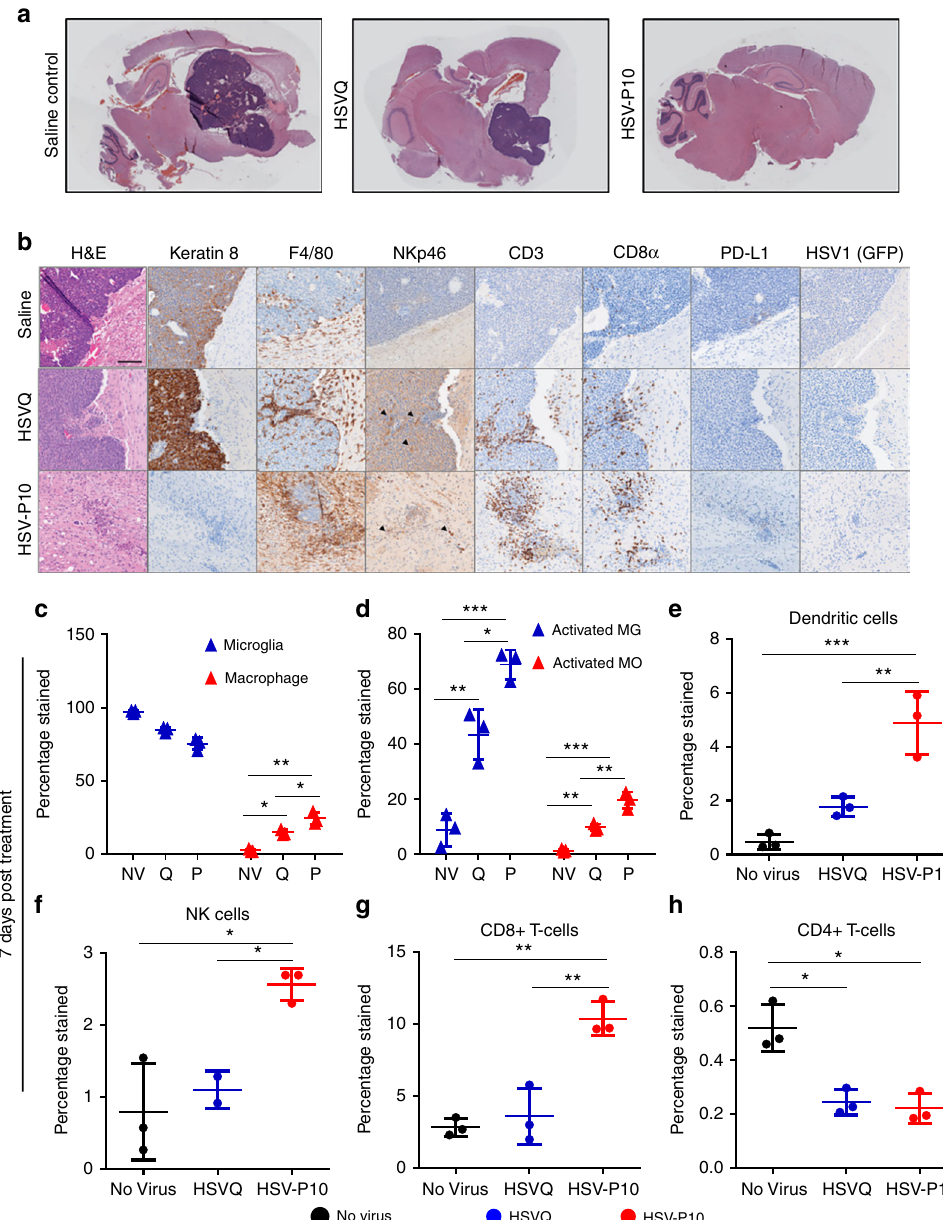
Fig. 8 HSV-P10 induces enhanced immune cell in fl ux towards infected tumors. Tumor-bearing FVB/N mice were treated with 1e5 pfu of HSVQ, HSV-P10, or saline control 8 days post tumor implantation. a Stitched 4X bright fi eld images of H&E stained sagittal sections of mouse brains 3 days post virus injection. b Representative 20X bright fi eld images of H&E, Keratin 8, F4/80, NKp46, CD3, CD8 α , PD-L1, and HSV1 (GFP) from sagittal sections of mouse brains 3 days post virus injection. Scale = 0.1 mm. c Ratio of macrophages (CD11b + F4/80 + CD45 bright ) to microglia (CD11b + F4/80 + CD45 dim ). d Percentage of cells in c positive for MHC-II. e Dendritic cell (CD11c + CD80 + MHC-II + ) in fi ltration. f NK cell (CD49b + NKp46 + ) in fi ltration. g CD8